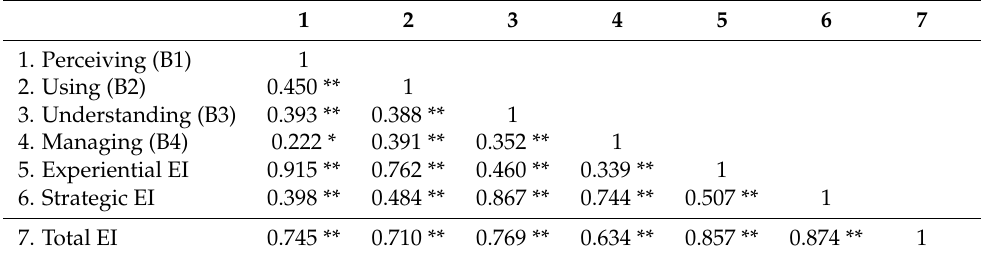
Table 1. Correlations between Mayer-Salovey-Caruso Emotional Intelligence Test (MSCEIT)